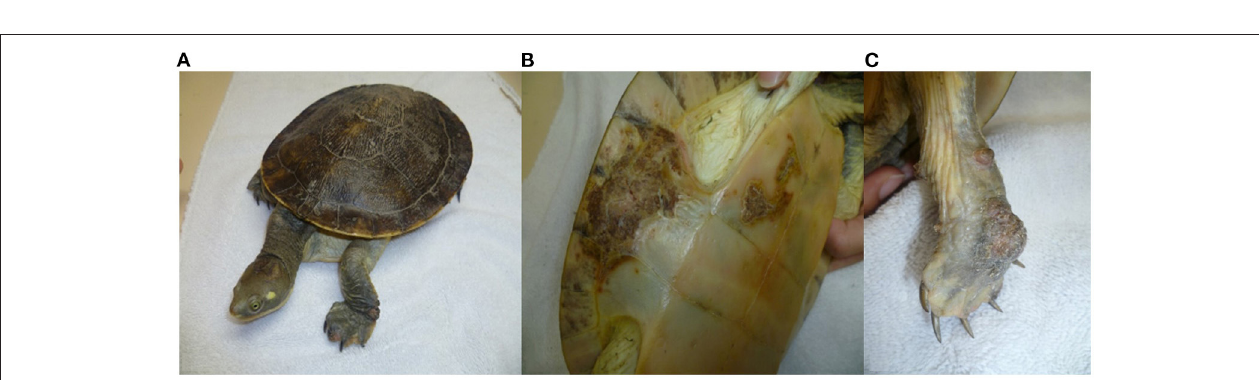
FIGURE 7 | Herpesvirus infection in freshwater turtle ( Emydura macquarii krefftii ) presented with proliferative and ulcerative lesions of the skin (A) , proliferative and crusted lesions on the bridge of the shell (B) , and proliferative lesion on the palmar aspect of the right forefoot (C) . “Adapted from Herpesvirus in a captive Australian Krefft’s river turtle ( Emydura macquarii krefftii )” by Cowan et al. (110). Copyright 2021 by John Wiley and Sons. Reprinted with permission.